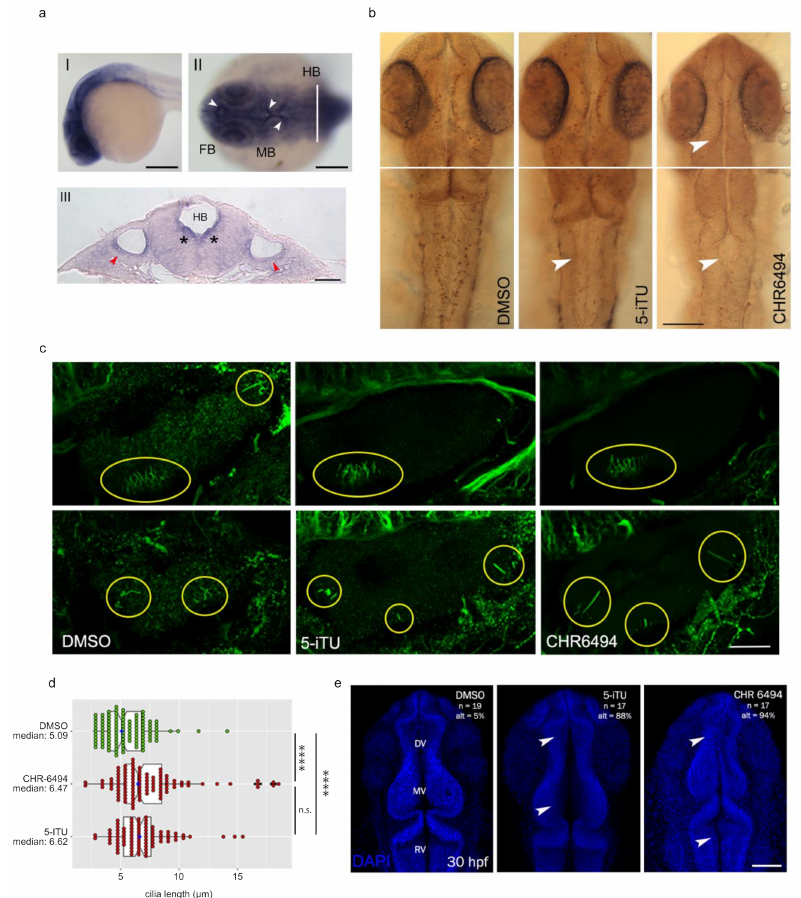
Figure 5. Haspin regulates cilia in the zebrafish embryo. ( a-I ) expression pattern of zebrafish Haspin at 24 hpf. Lateral view, anterior to the left. The gene is expressed in all brain vesicles; ( a-II ) dorsal view of the cephalic region, anterior to the left. The neuromeres are all heavily labeled, with a further intense signal pinpointing the whole periventricular portion of the developing brain (white arrowheads); ( a-III ) histological section conducted according to the plane shown in a-II (white line). The signal is clearly visible in the cells surrounding the ventricles (black asterisks) and the cells of the otic vesicle (red arrowheads). FB, forebrain; MB, midbrain; HB, hindbrain; ( b ) embryos were treated with either DMSO, 5-ITU, or CHR-6494 until 48 hpf, when they were processed for immunohistochemistry with a phosphorylated H3-T3 antibody. Dorsal views are shown; white arrowheads indicate points of reduced histone phosphorylation; ( c , d ) embryos were incubated with DMSO or Haspin inhibitors for 72 h when they were fixed and processed for immunofluorescence against acetylated tubulin. Yellow circles indicate ciliated regions, two different z stacks for each sample are shown; cilia length was measured and is reported in d; boxes include 50% of the data points, notch represent confidence interval (median ± 1.58 IQR/sqrt(n)). t -test was applied as a statistical measurement, n.s.; not significant, * p < 0.05, **** p < 0.001; ( e ) embryos were treated with DMSO or Haspin inhibitors for 30 h and then stained with DAPI to monitor neural tube morphology. Scale bars: ( a-I ) 200 µ m; ( a-II ) 50 µ m; ( a-III ) 10 µ m; ( b ) 100 µ m; ( c ) 25 µ m; ( e ) 100 µ